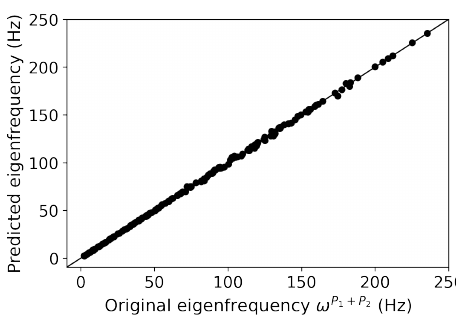
Figure 7. Convergence curve of network training.